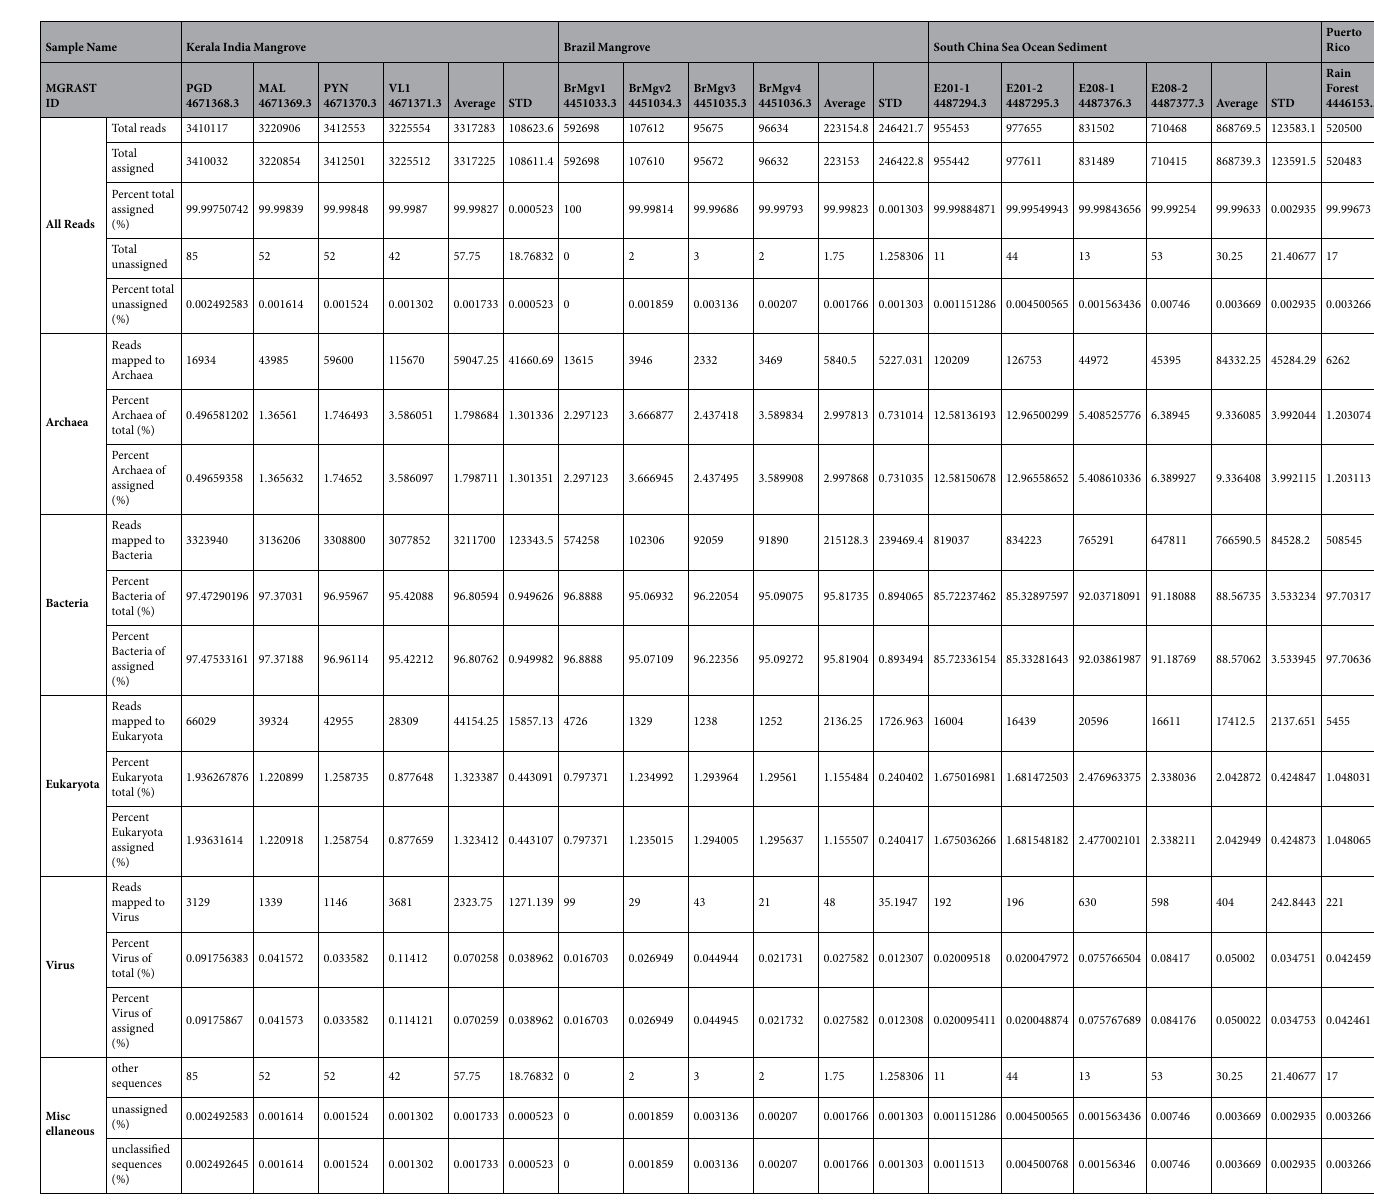
Table 1. Summary of reads and distribution across kingdoms in the samples from India, Brazil, Puerto Rico and from the isolates taken from the South China